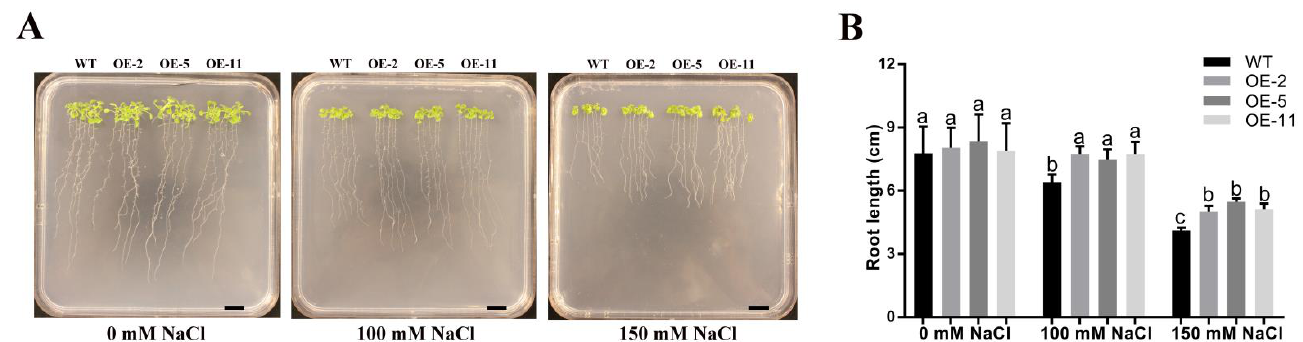
Figure 3. Overexpression of GmGSTU23 relieved the inhibition of root elongation by salt stress. ( A ) Phenotypes of the GmGSTU23 transgenic lines in plate culture. ( B ) Analysis of root elongation of seedlings. Scale bar = 1 cm. The bars represent the average ± SD of three replicates. Different letters above the bars indicate significant differences among the treatments ( p < 0.05). WT, wild type; OE-2, OE-5, OE-11: GmGSTU23 transgenic lines.